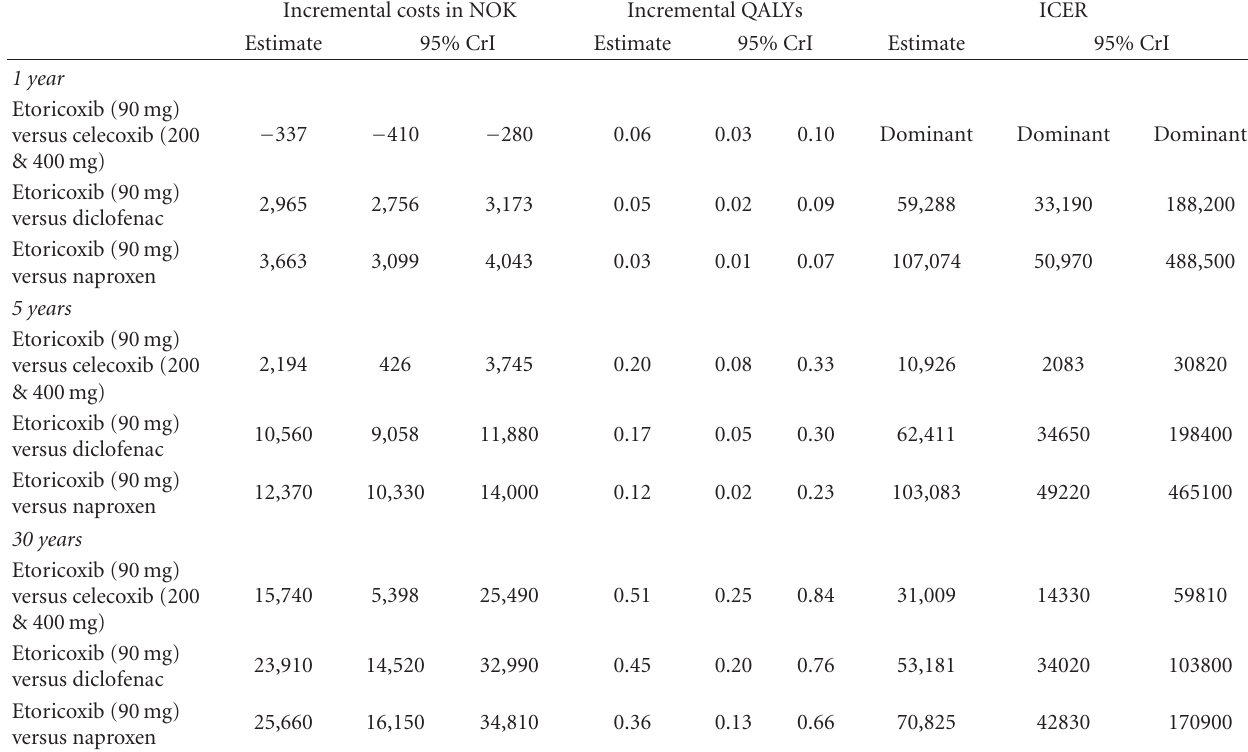
Table 6: Cost-e ff ectiveness of etoricoxib relative to other interventions when anti-TNF α costs are set to zero. Incremental costs in NOK Incremental QALYs ICER